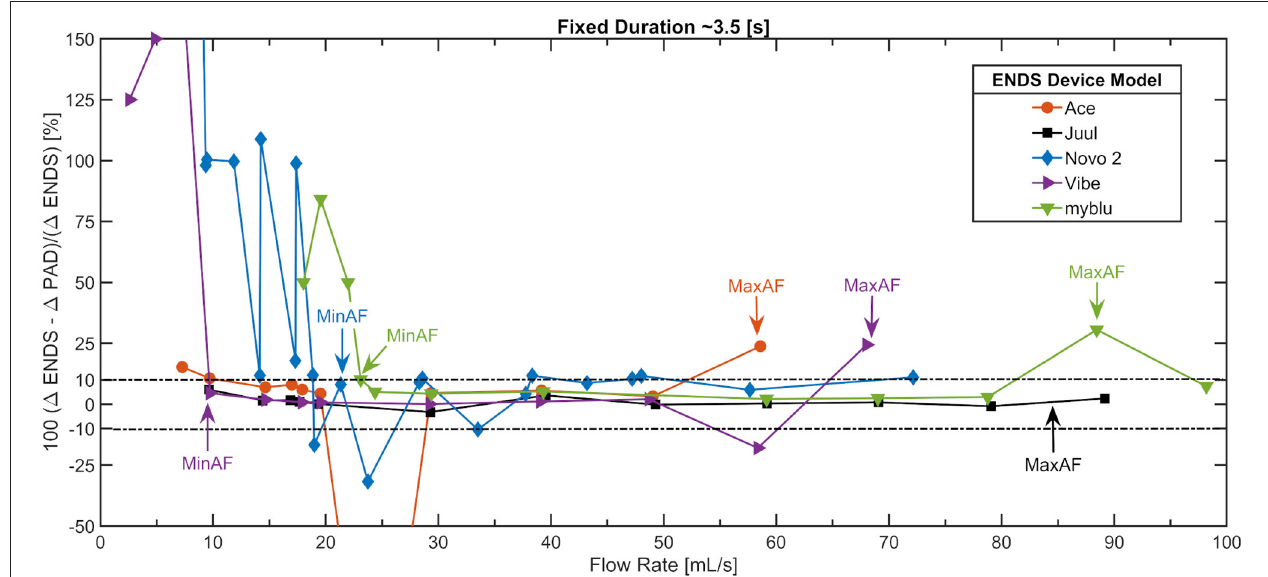
FIGURE 4 | Relative gravimetric measurement error related to operator observed aspiration during the “Variable Flow Rate set” of conditions shown in Figure 1 for 5 of the 13 ENDS. A relative mass error of 1 M > ± 10% at flow rates exceeding the activation flow rate was consistently associated with visual evidence of liquid aspiration. Puffs were square-wave with nominal puff duration of 3.5 (s) and 30s puff